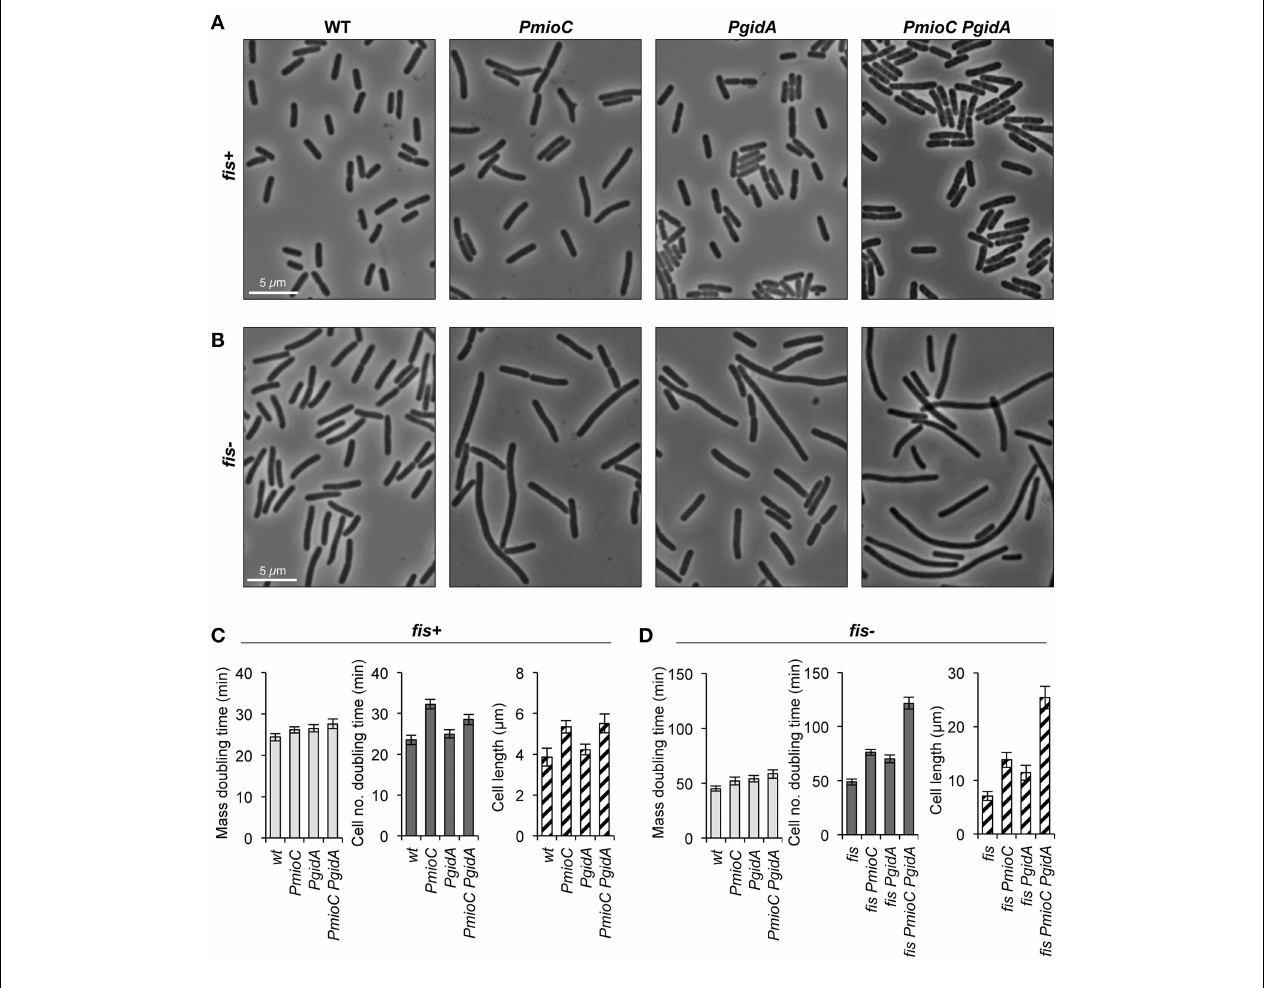
for mass doubling time by optical density at 600nm (light gray bars), cell number doubling time by flow counting in a Coulter particle counter (dark gray bars), and cell length at OD600 = 0.2 by direct microscopic observation (hatched bars, n = 500–600 cells). Values are means of 5 independent experiments ± 1 standard deviation